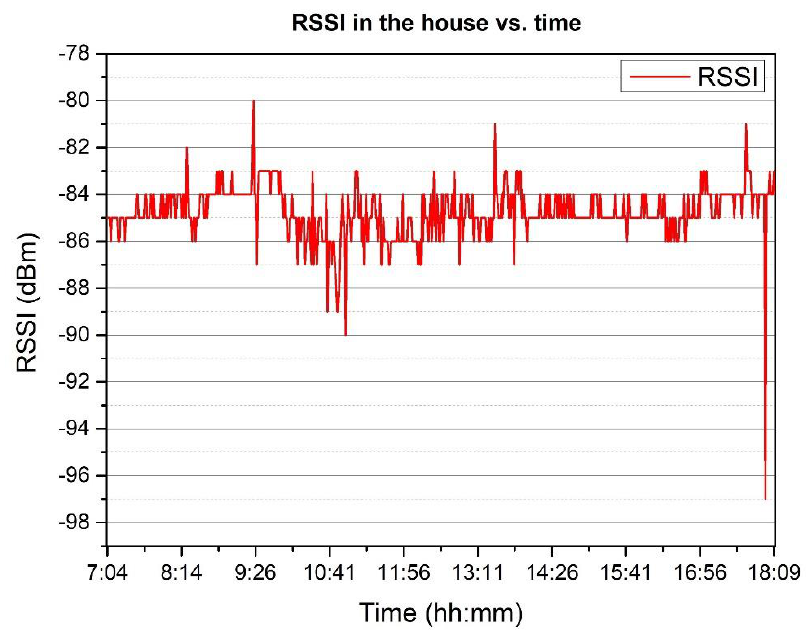
Figure 13. The RSSI measured in the house during the day.